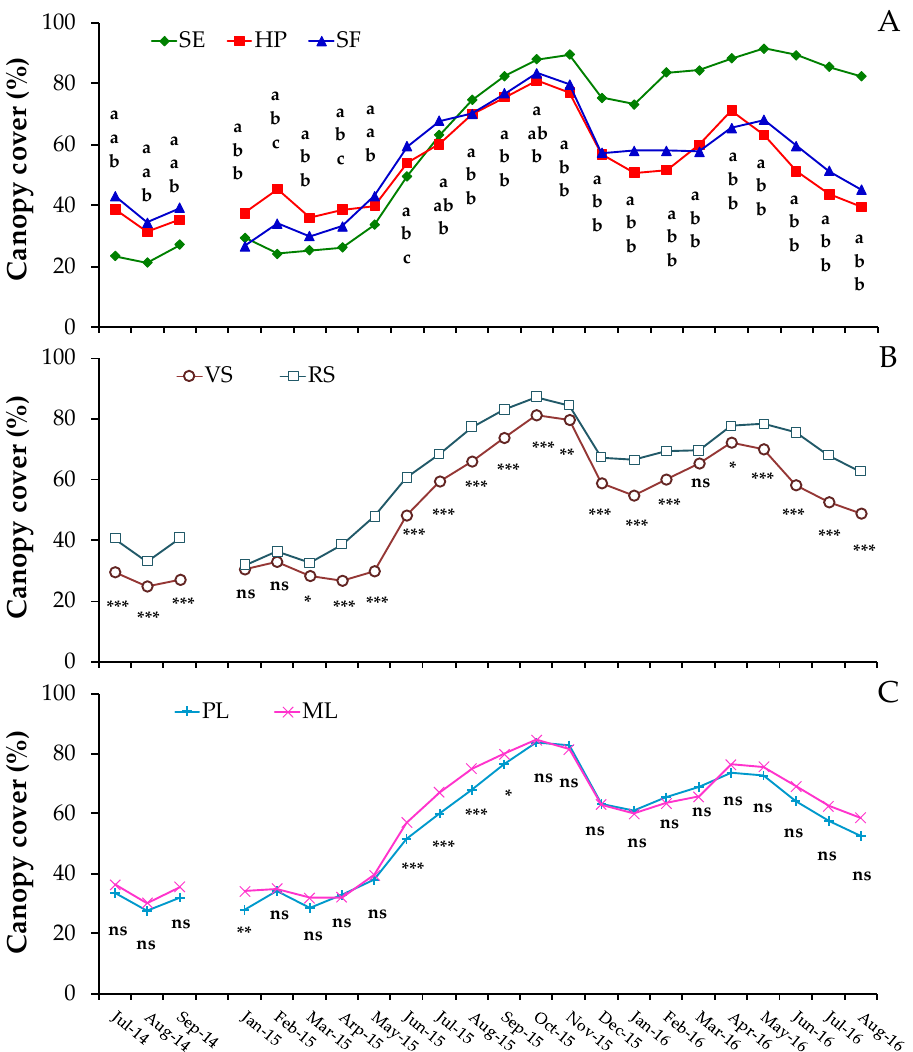
Figure 8. Variation of canopy cover during the experiment as affected by plant mix ( A ), substrate ( B ), and drainage/storage layer ( C ). SE = Sedum mix, HP = herbaceous perennials, SF = suffruticose, VS = volcanic substrate, RS = recycled crushed brick substrate, PL = preformed plastic drainage/storage layer, ML = mineral drainage/storage layer. On each date, values with different letters are significantly different according to Tukey’s HSD test p ≤ 0.05). *, **, and *** = significant for p- values of < 0.05, <0.01, and <0.001 according to the analysis of variance (ANOVA). ns = not significant.